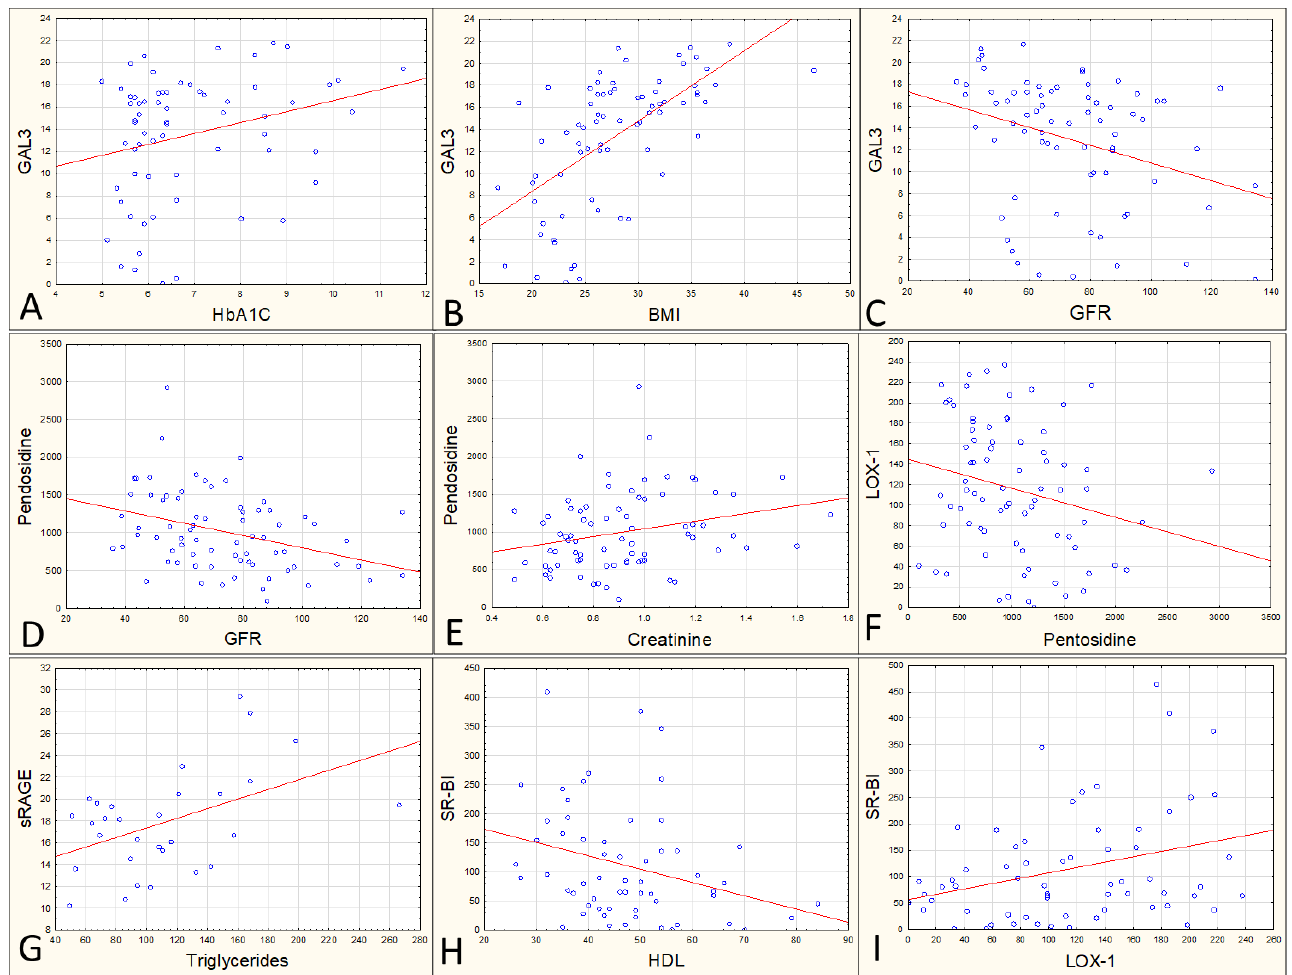
Figure 1. Scatterplots for selected pairs of analyzed parameters. Scattering of results between GAL3 and HbA1c (panel A ), between GAL3 and BMI (panel B ), between GAL3 and GFR (panel C ), between pentosidine and GFR (panel D ), between pentosidine and creatinine (panel E ), between pentosidine and LOX-1 (panel F ), between sRAGE and triglycerides (panel G ), between SR-BI and HDL (panel H ), and between LOX-1 and SR-BI (panel I ).